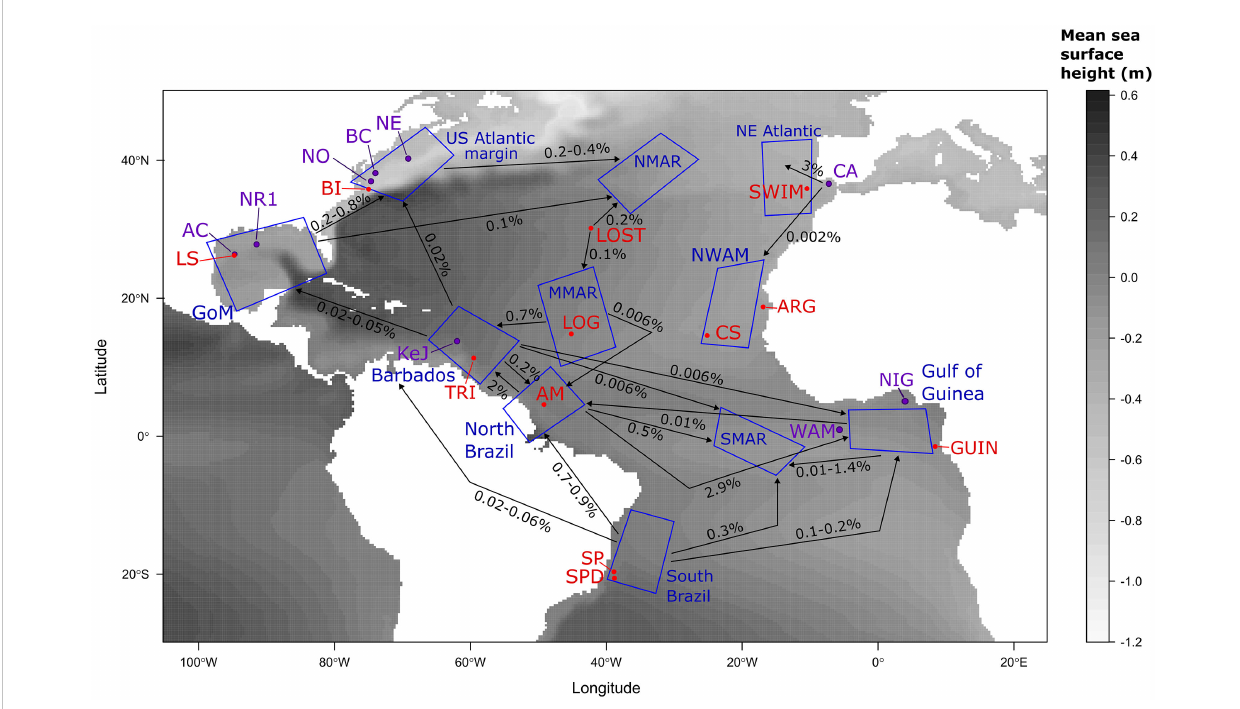
FIGURE 5 Larval dispersal connectivity map obtained using larval dispersal fl uxes simulated by the oceanic circulation model VIKING20X. Mean fl uxes were calculated between spawning areas (red and purple points) and settlement regions (blue polygons). Arrows show the range of mean values observed for all sites within settlement regions. Details on site per site values can be found in Table 6. See Figure 1 for spawning areas and settlement regions abbreviation de fi